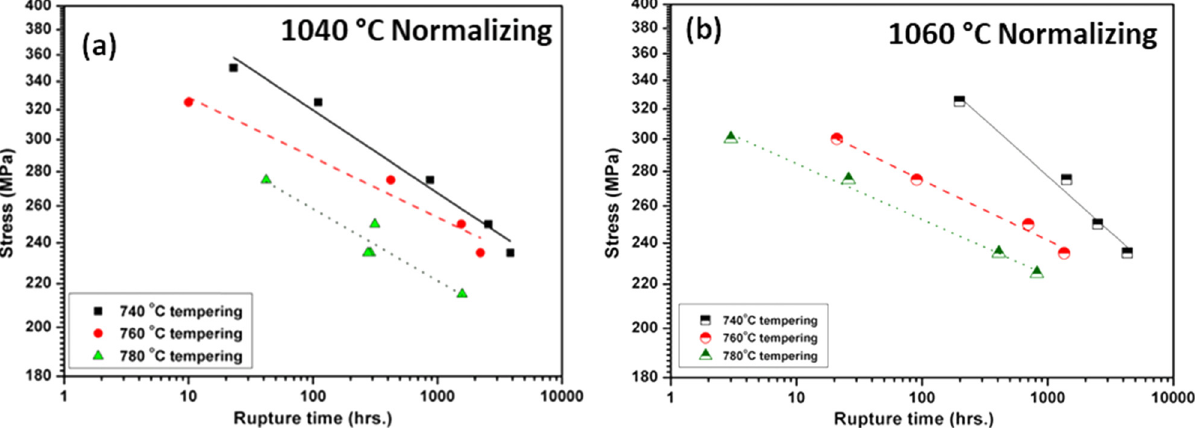
Figure 6: Summary of the stress rupture data revealing the effect of tempering temperature for creep tests at 600°C, for normalizing temperatures of ( a ) 1040°C ( b )